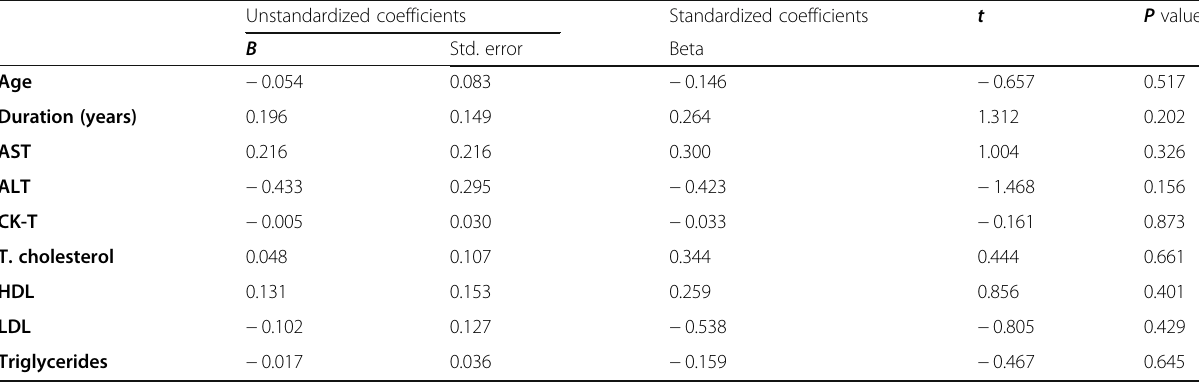
Table 6 Linear regression analysis displaying independent predictors of IL-6 after 6 months Unstandardized coefficients